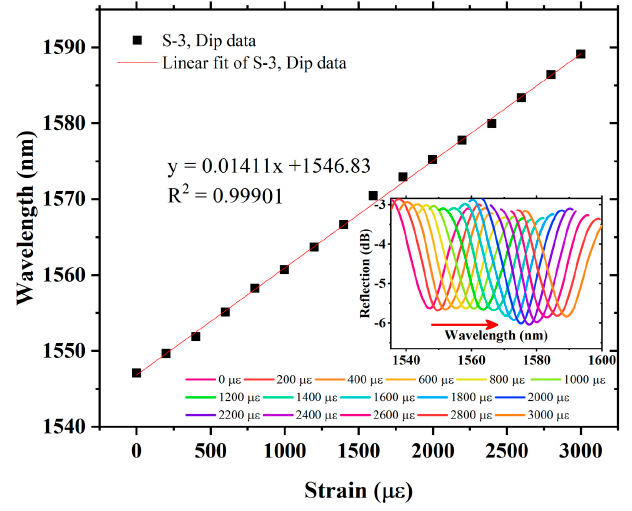
Figure 11. Sensitivity and linear correlation function of S-3, and inset exhibits spectral evolution of envelope dip data.